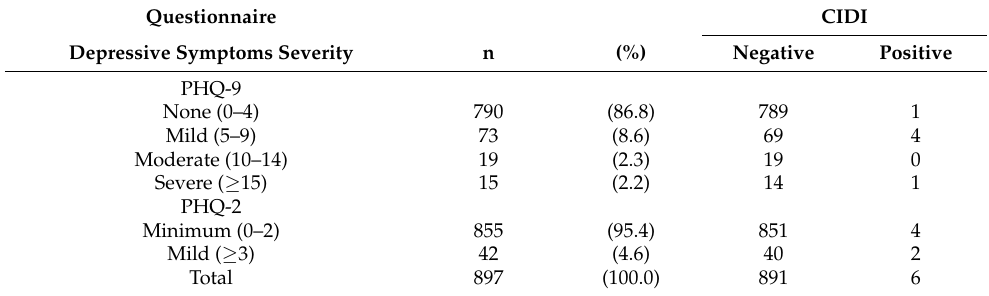
Table 2. Distribution of PHQ scores and 12-month-CIDI Major Depressive Disorder (n =